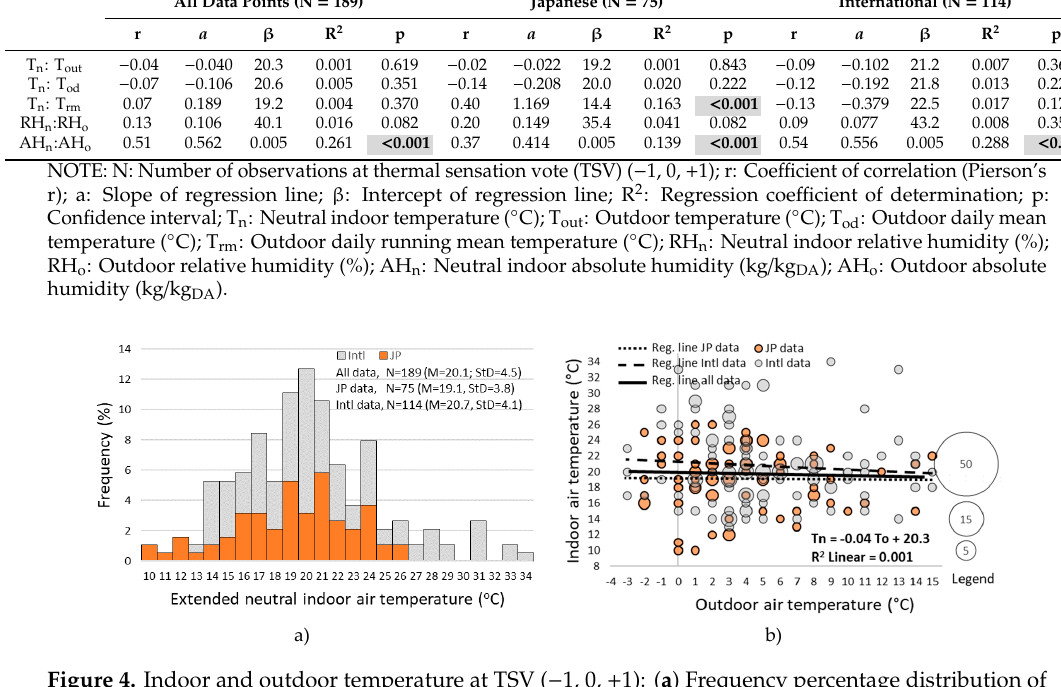
Figure 4. Indoor and outdoor temperature at TSV ( − 1, 0, +1): ( a ) Frequency percentage distribution of neutral indoor air temperature; ( b ) correlation between indoor and outdoor air temperature at the vote.